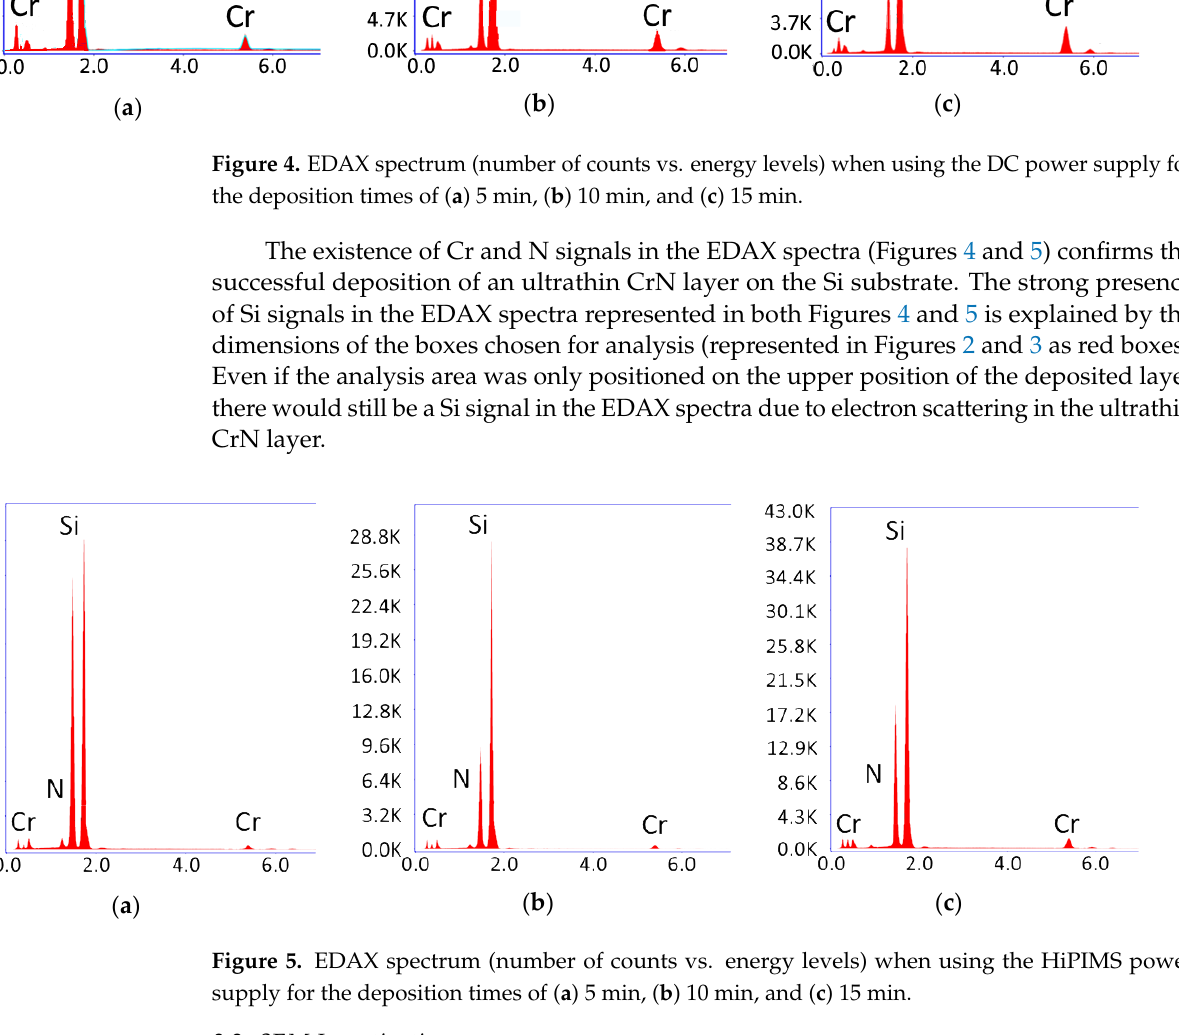
Figure 5. EDAX spectrum (number of counts vs. energy levels) when using the HiPIMS power supply for the deposition times of ( a ) 5 min, ( b ) 10 min, and ( c ) 15 min.